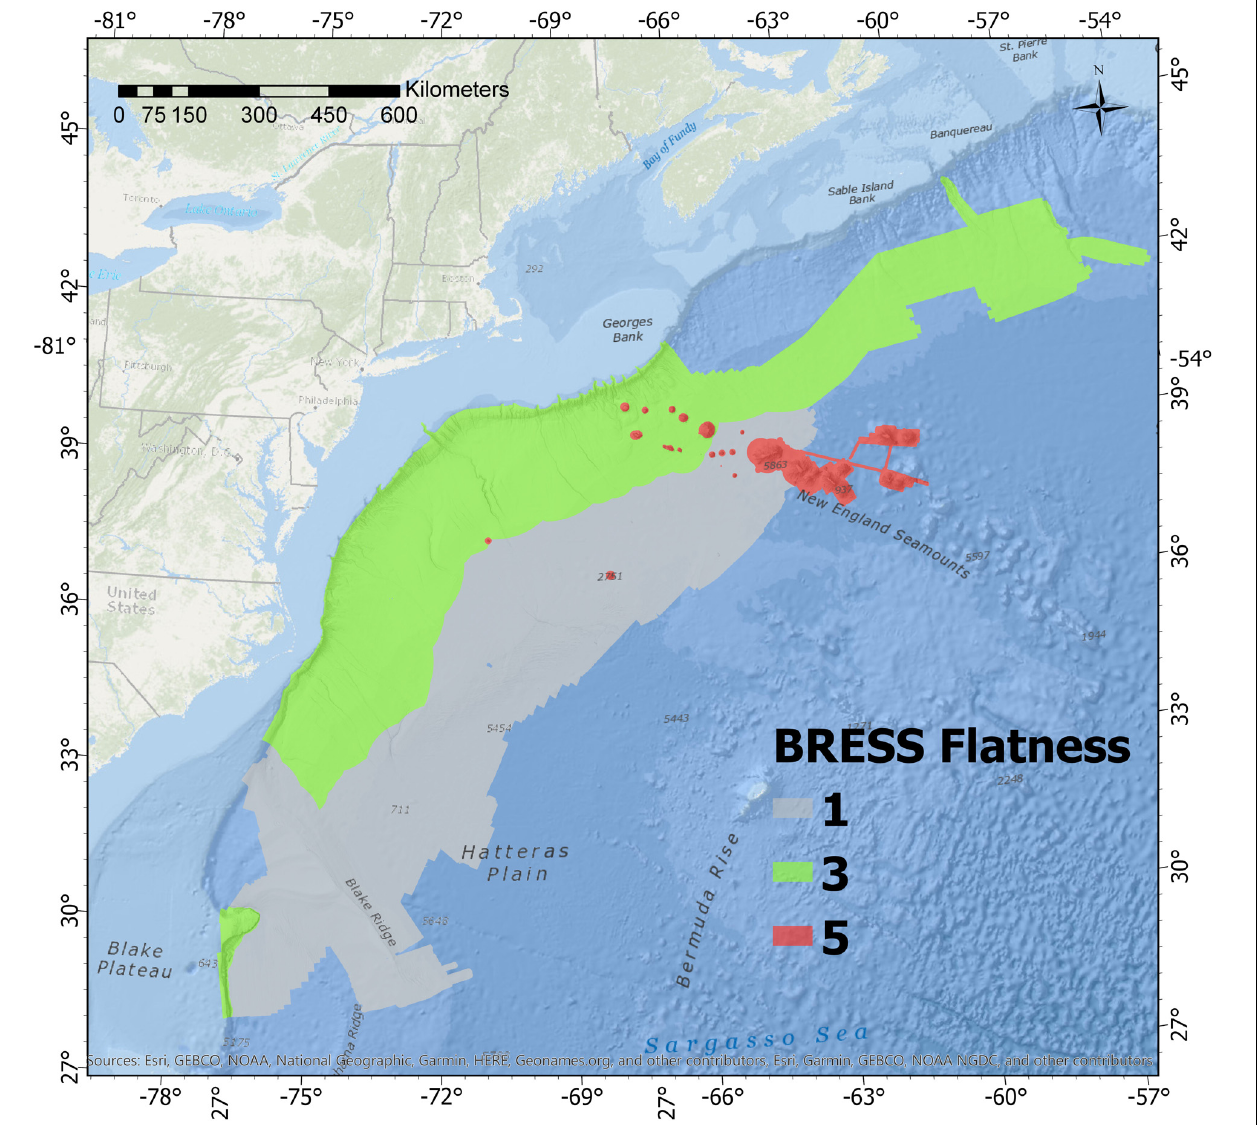
FIGURE 2 | Flatness parameter mask used to apply different flatness values of the BRESS landform algorithm to different regions of the Atlantic Margin study area. Parameter of 5.0 degrees (red) applied to the seamounts, 3.0 degrees (green) applied to the continental slope, and 1 degrees (gray) applied to abyssal areas. Bathymetry data shown in the background for